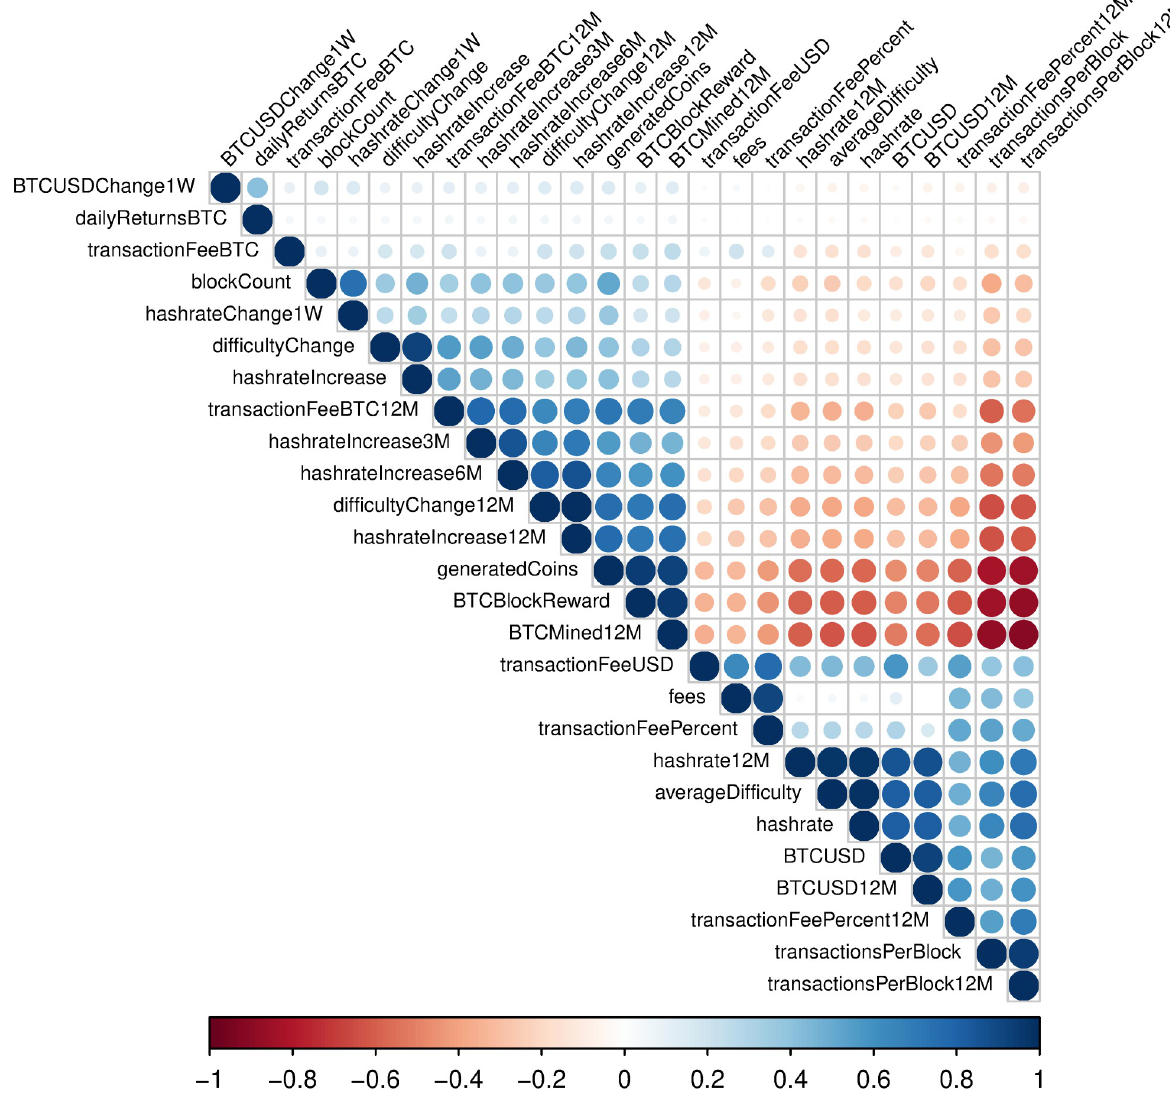
Fig 8. Correlations of the analyzed variables. The plot presents Pearson correlation coefficients among analyzed variables. Blue and red colors denote positive and negative correlations, respectively. The size of the circles is proportional to the absolute value of correlations. The time period for this data is between 2013/05/01 and